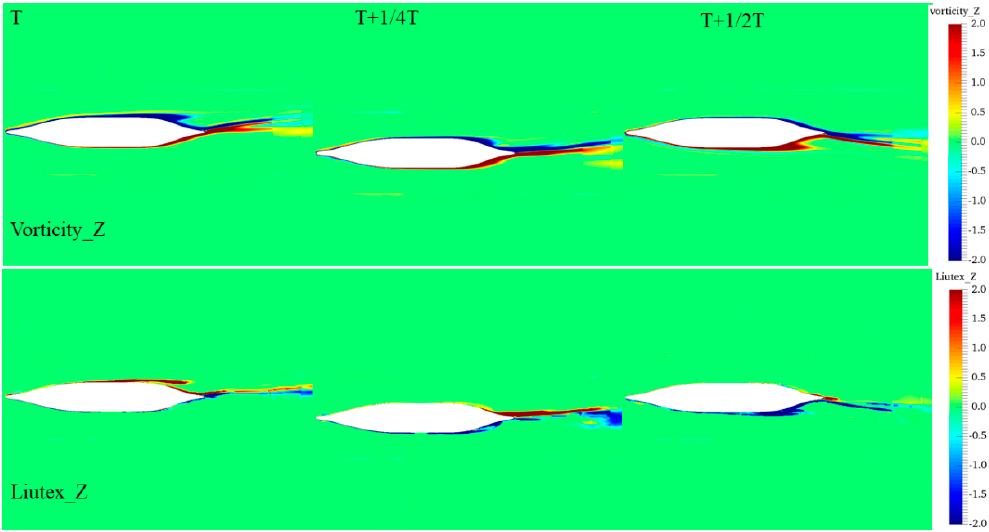
Figure 15. Vertical vorticity (top) and Liutex (bottom) at z / L pp = − 0.03572 in CASE PS16.